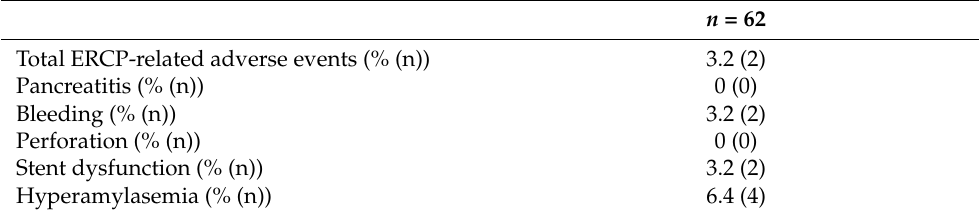
Table 5. Adverse events.